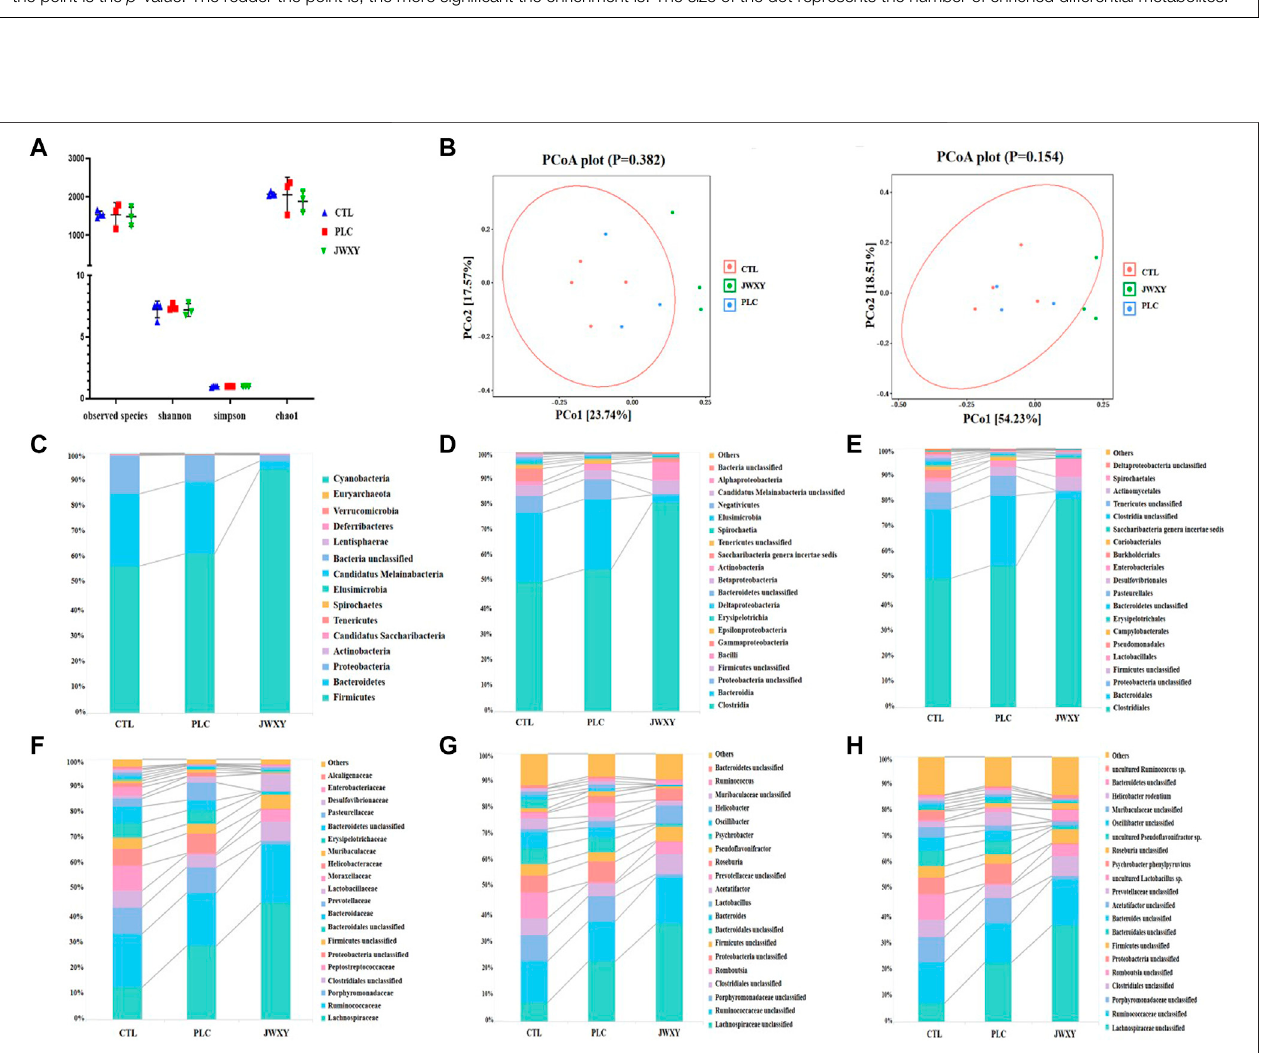
FIGURE 5 | Proportion of intestinal microbe in CTL, PLC, and JWXY groups. (A) Alpha diversity index among the three groups. (B) Beta diversity distance PCoA analysis (unweighted and weighted). (C) Composition proportion of bacteria phylum in each group. (D) Composition proportion of bacteria class in each group. (E) Composition proportion of bacteria order in each group. (F) Composition proportion of bacteria family in each group. (G) Composition proportion of bacteria genus in each group. (H) Composition proportion of bacteria species in each group.